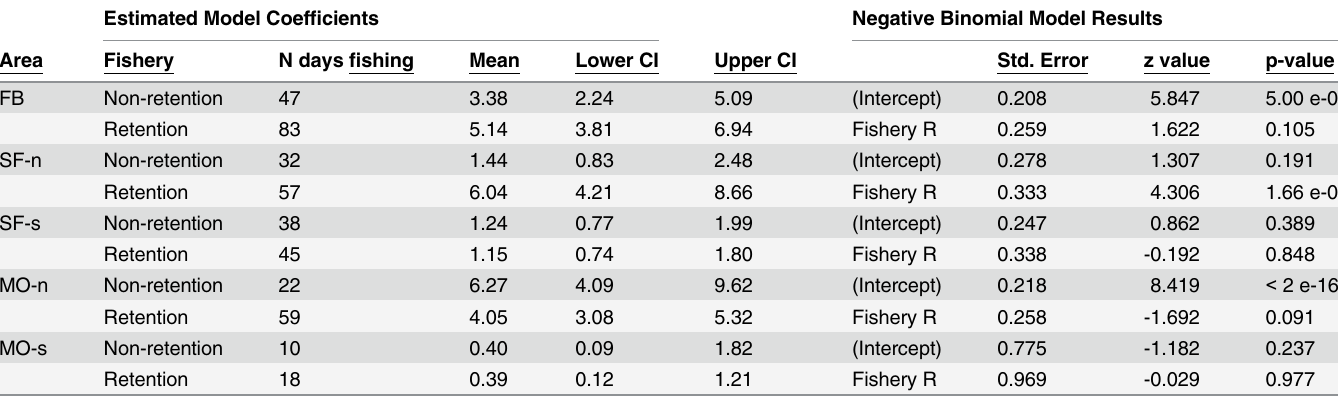
Table 6. Comparison of catch per unit effort (CPUE) for non-retention and retention fisheries sampling techniques.